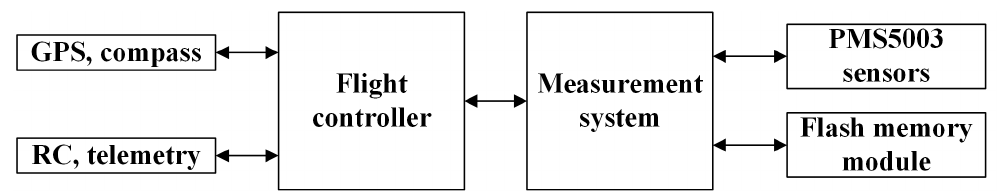
Figure 6. Simplified block diagram of the designed